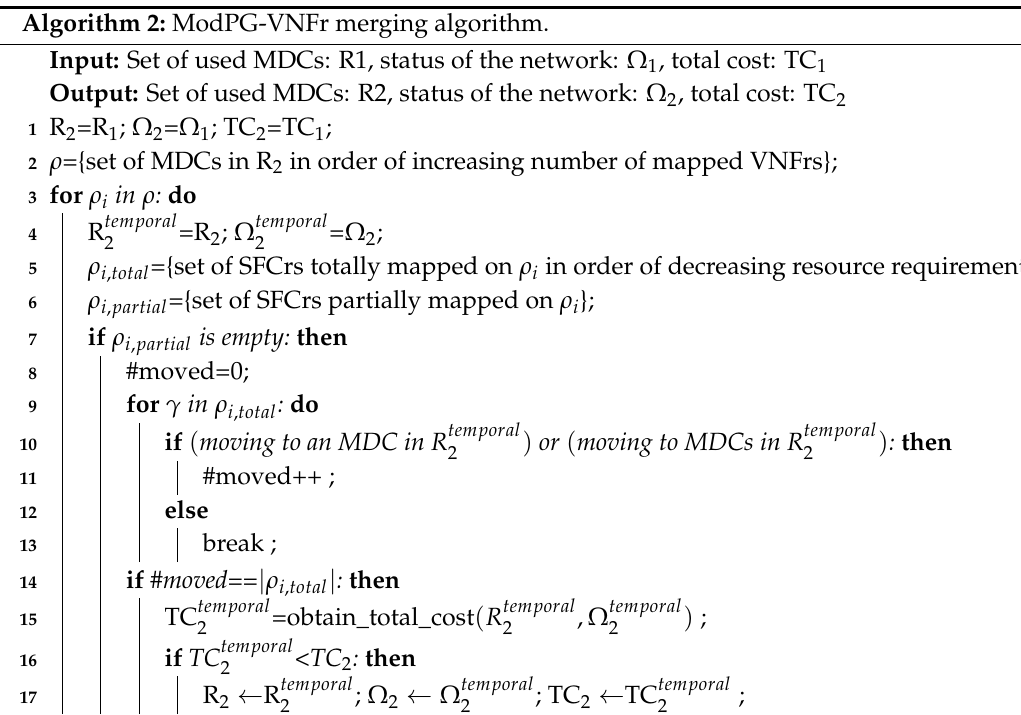
Algorithm 2: ModPG-VNFr merging